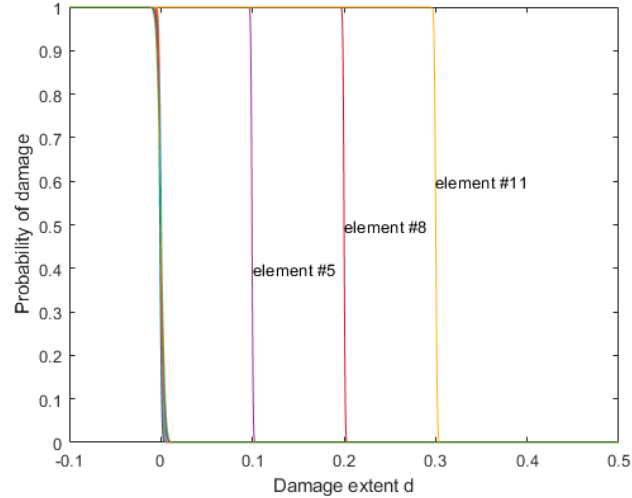
Figure 11. Probability curve of damage extent for beam model.